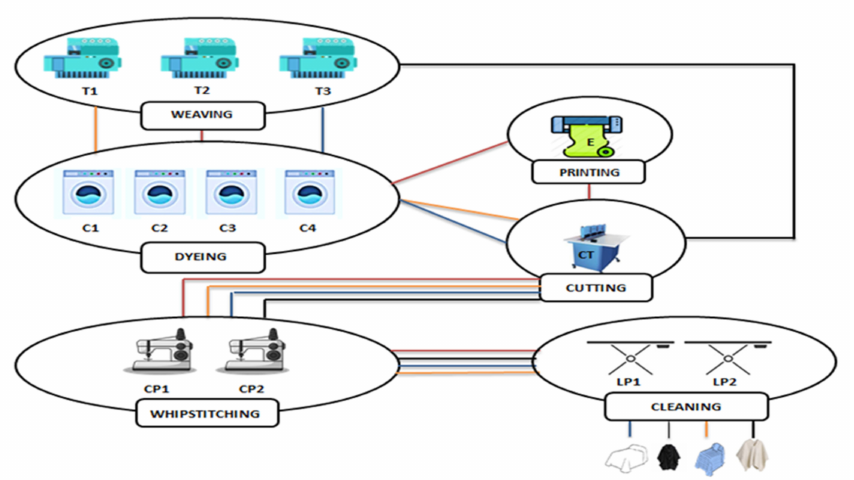
Figure 6. Process stages and sequence of operation in the textile flexible job shop system